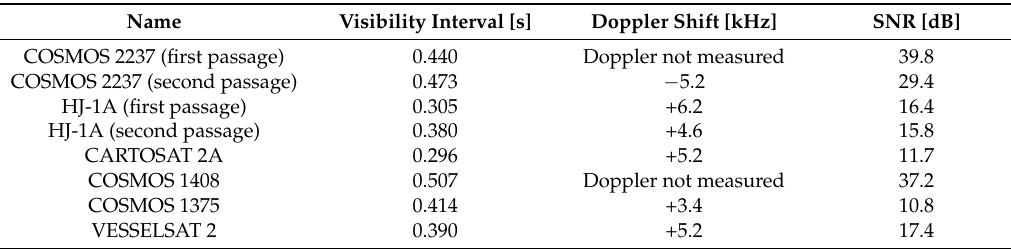
Table 4. Experimental results for every space debris observed.